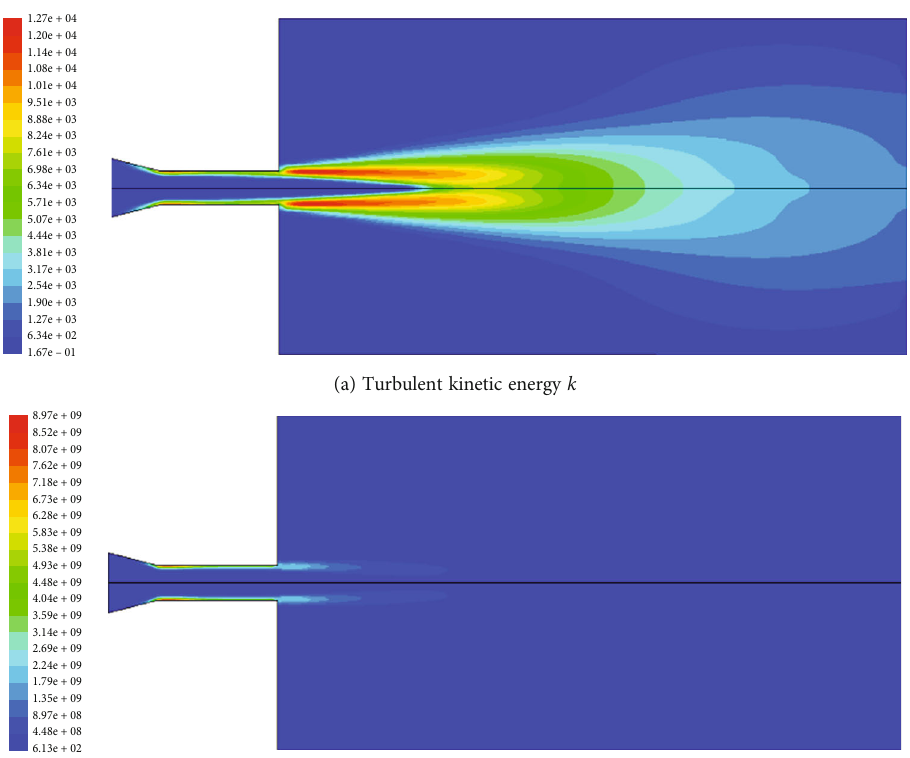
(b) The dissipation rate of turbulent kinetic energy ε Figure 4: Turbulent kinetic energy distribution of the water